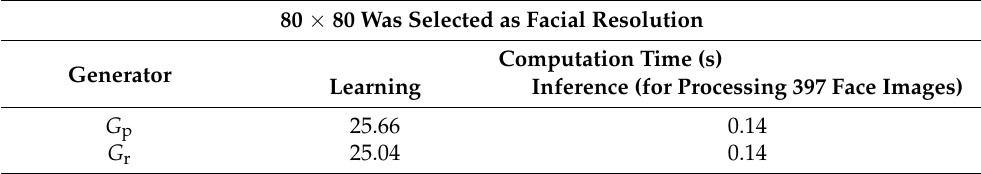
Table 1. Computation Time For G p and G r . Here, 80 × 80 was selected as facial